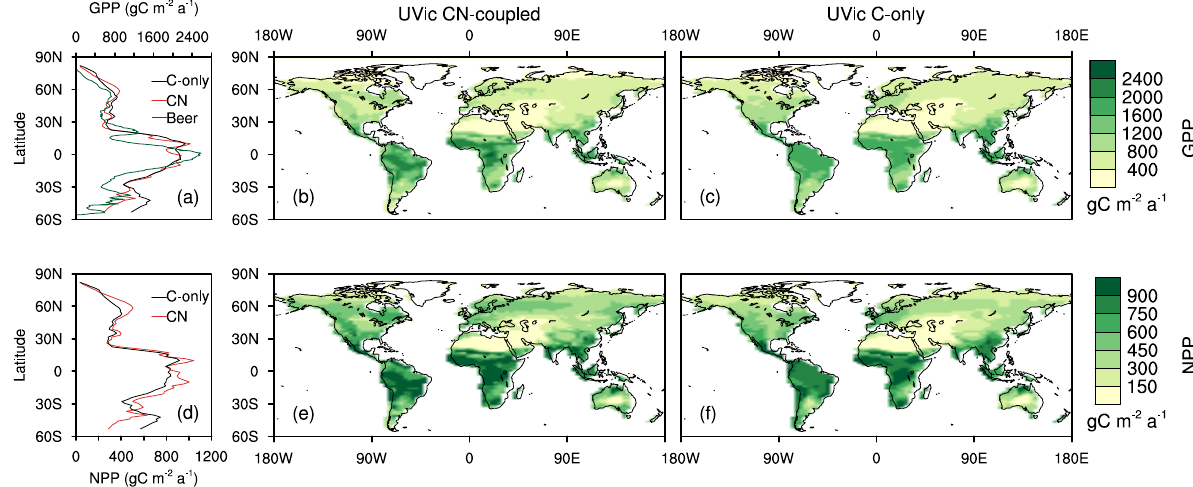
Fig. 6. Mean 1980–1999 gross primary production (GPP) (top row) and net primary production (NPP) (bottom row) for UVic C-only and UVic-CN. The line graphs on the left hand side are zonal averages of the UVic C-only (black), the UVic-CN (solid red) data shown in the maps per 1.8 ◦ latitude and the median data-driven zonally averaged GPP values taken from Beer et al. (2010)